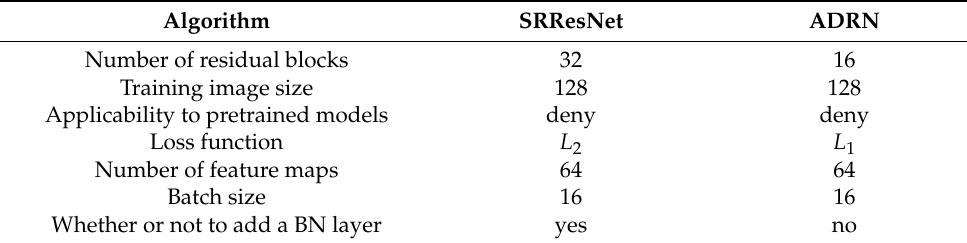
Table 5. Network parameters for each algorithm.